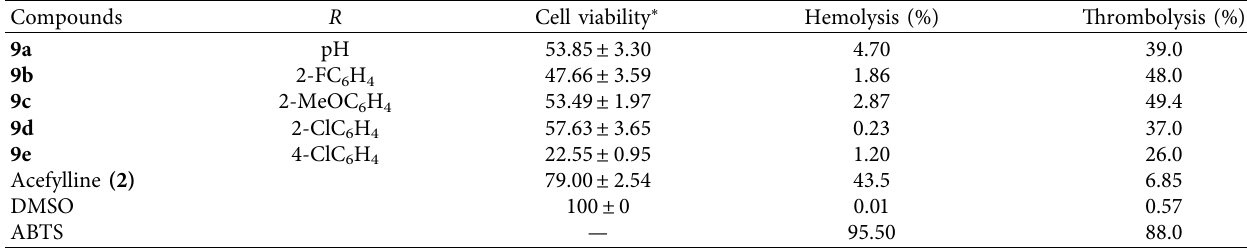
Table 1: Biological activities of 9a – 9e along with that for 2 , solvent, and ABTS.